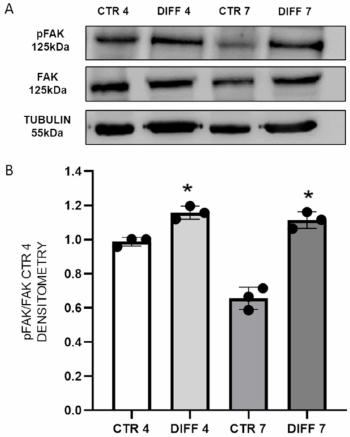
Figure 2. ( A ) Western blot analyses with anti-pFAK, anti-FAK and anti-tubulin antibodies on H9c2 cell lysates after 4 and 7 days of differentiation. Proteins were revealed on total lysates, and all results were normalized with respect to FAK expression at day 4. ( B ) Densitometry results obtained from three different experiments are expressed as mean ± SD. Statistical significance with respect to relative controls (* p ≤ 0.05).